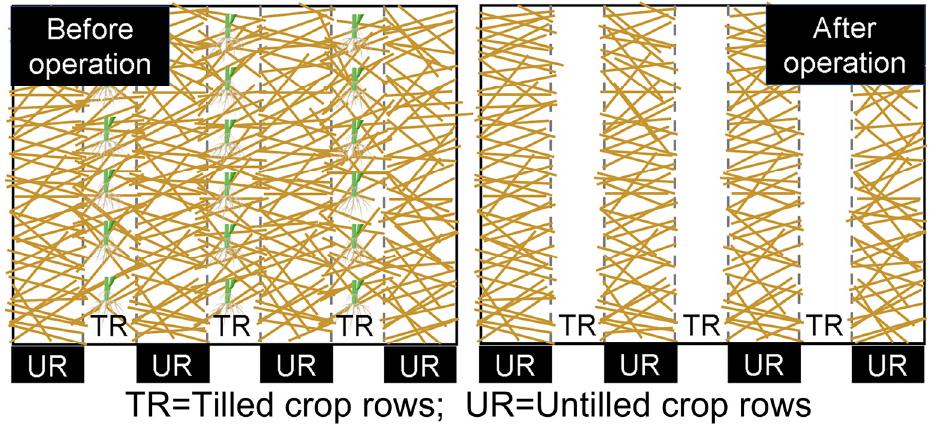
Figure 1. Effectiveness of maize straw mulch strip-till stubble-crushing operation under-conservation agriculture system.